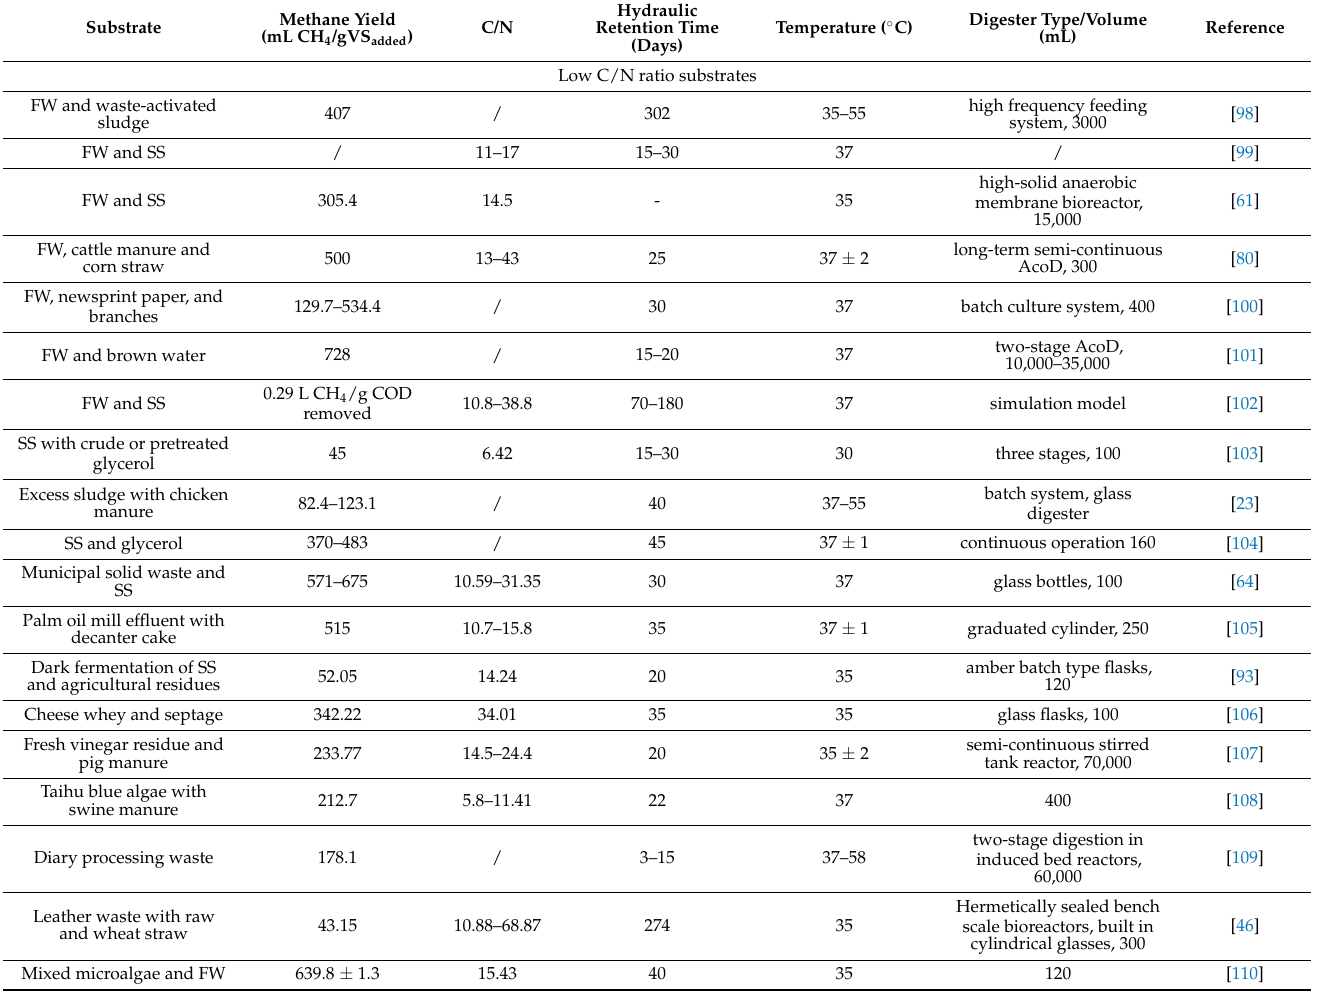
Table 1. Methane yield, C/N ratio and digester type for different substrate mixtures in